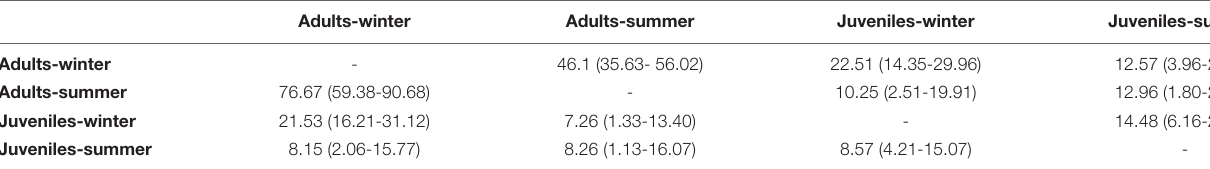
TABLE 5 | Percentage of Bayesian Standard Ellipses Area (SEA B ) overlap between European hake adults and juveniles for summer and winter.